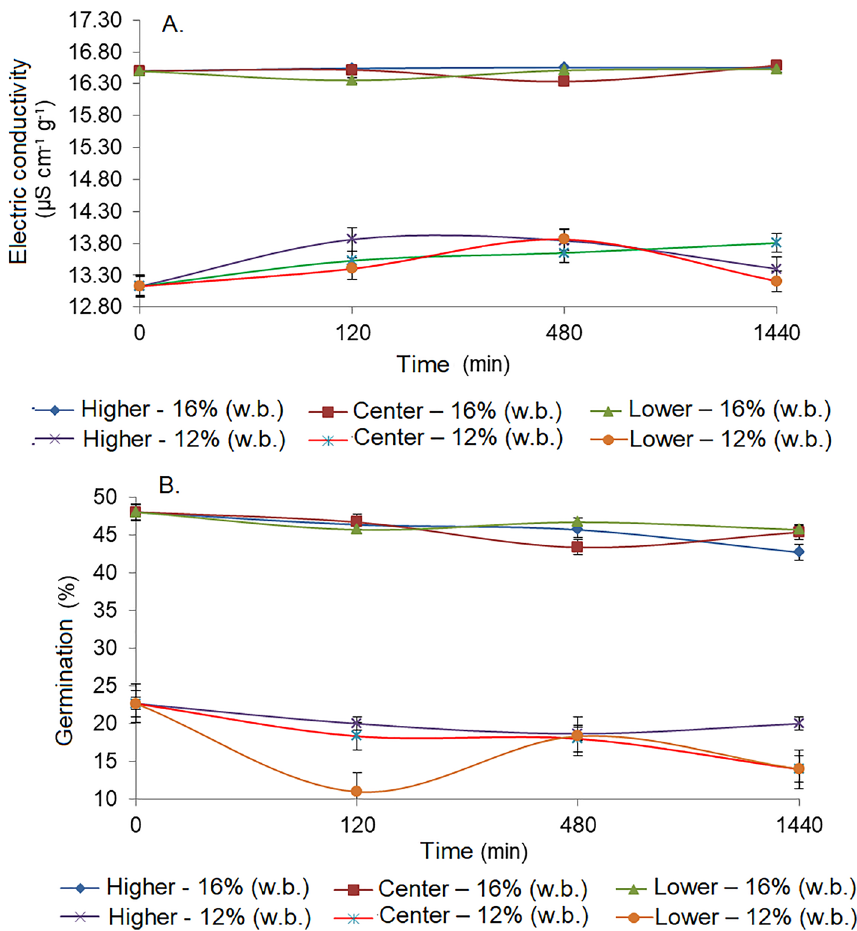
Figure 6. Evaluation of the cell structure of corn grains by the electrical conductivity test ( A ) and by the germination percentage ( B ) of corn grains with 12 and 16% moisture content (w.b.) over